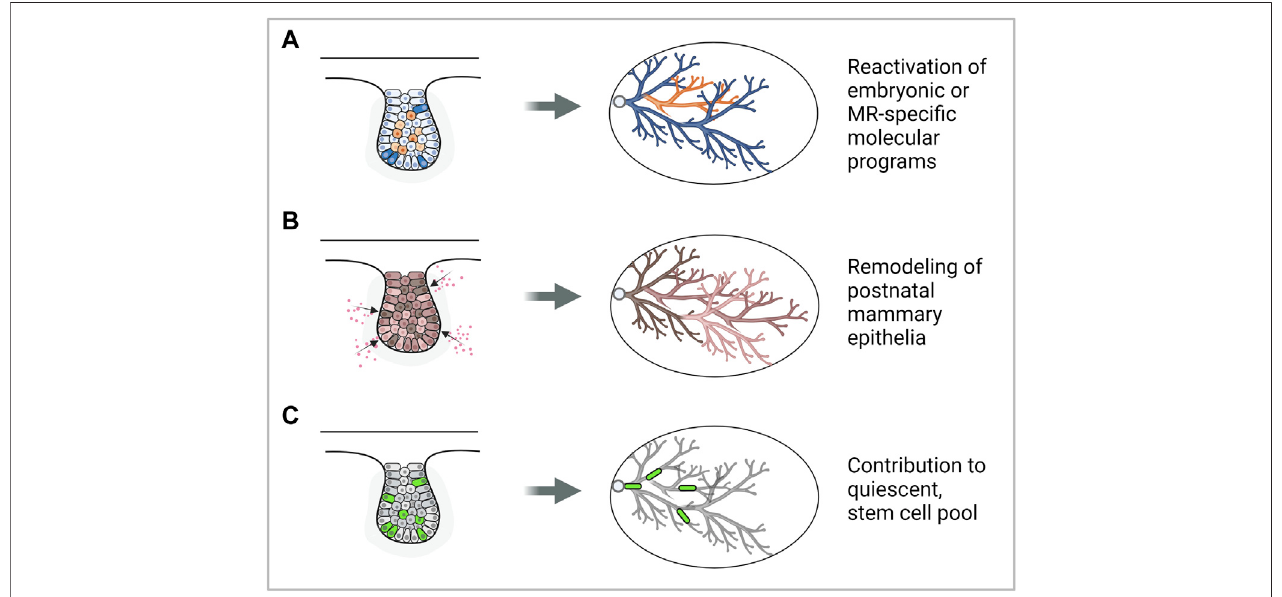
FIGURE 1 | Modes by which the embryonic mammary gland may contribute to breast cancer development. (A) Reactivation of embryonic mammary gland genes or signaling pathwaysmay promote cancer development. (B) Exposure tocarcinogens may remodel the postnatal mammary gland and increase breast cancer risk. (C) Embryonicmammaryglandcellsmaycontributetothestemcellpoolinthepostnatalmammaryglandwhichmaybecellsoforiginofcancer.Note:arepresentativeMRis depicted, however, each mode could be plausibly applied to MRs in other stages of development. Figure created with BioRender.